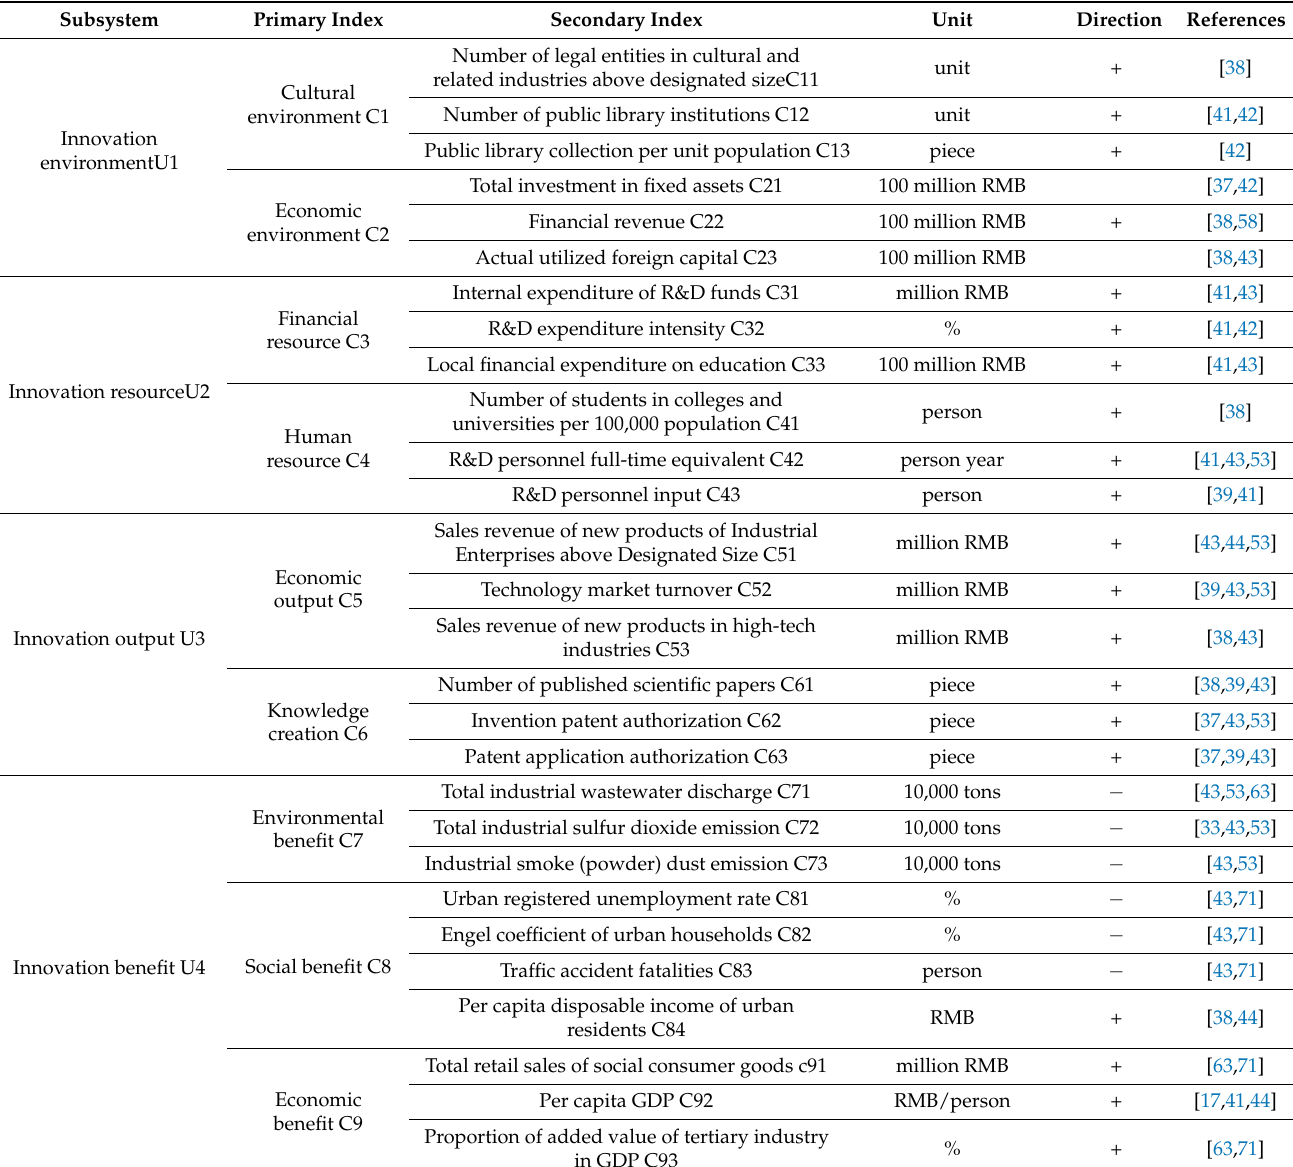
Table 2. Evaluation index system of coupling coordination development of regional innovation EROB composite